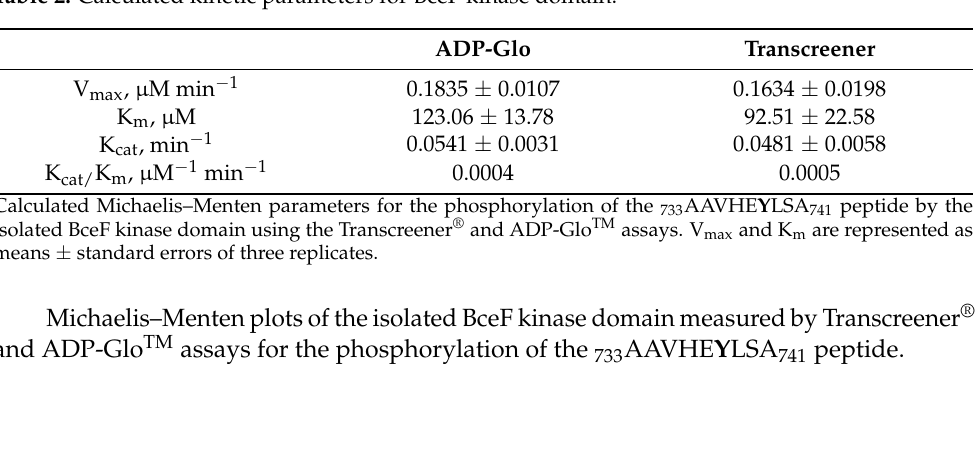
Table 2. Calculated kinetic parameters for BceF kinase